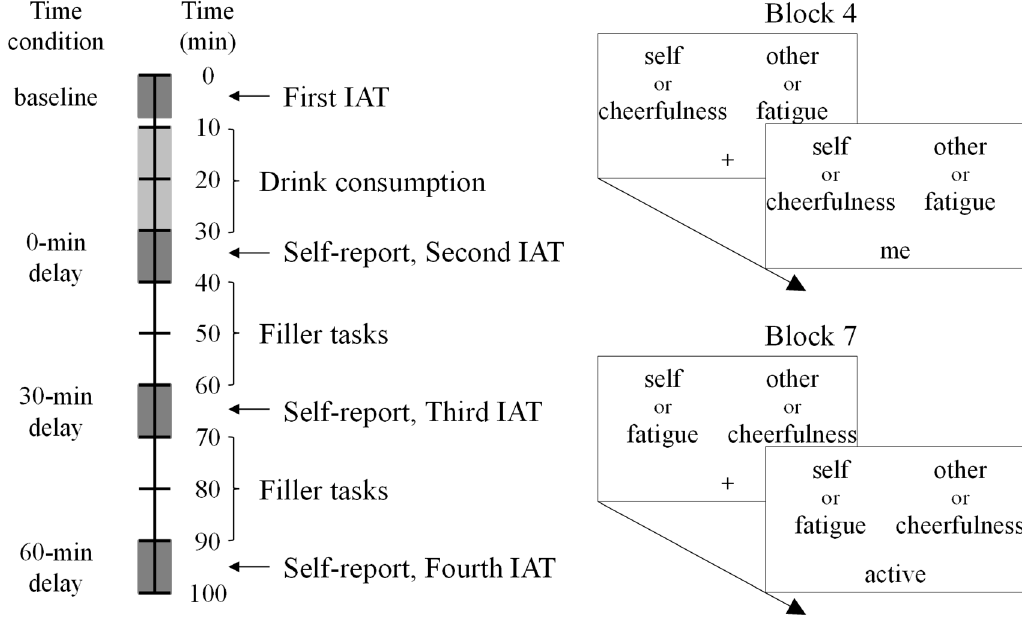
Figure 1. (Left) The sequence of events in one experimental session. The dark gray boxes represent administration of the Implicit Association Test (IAT) and the intoxication self-report. The light-gray box represents the time of consumption of the beverage. One IAT session (and one self-report pertaining to intoxication) took approximately 8 min (and 2 min) to complete. Two filler tasks were conducted during the inter-IAT periods (approximately 20 min) to avoid having participants fall asleep. ( Right ) Schematic representations of the IAT screen on the critical blocks (Blocks 4 and 7). Note that the category labels and target words in the display were shown in Japanese in the present study.